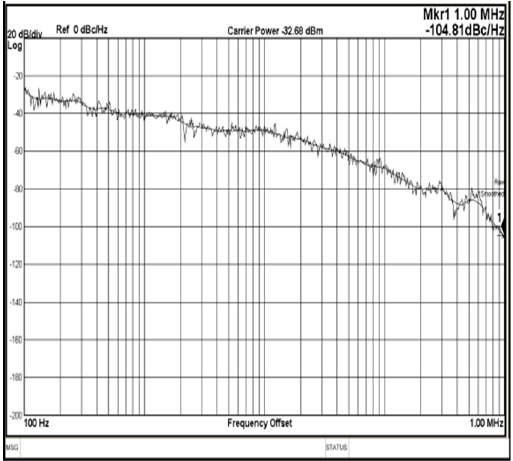
Figure 11. Measured phase noise curve of the proposed VCO (at oscillation frequency of 1 GHz).